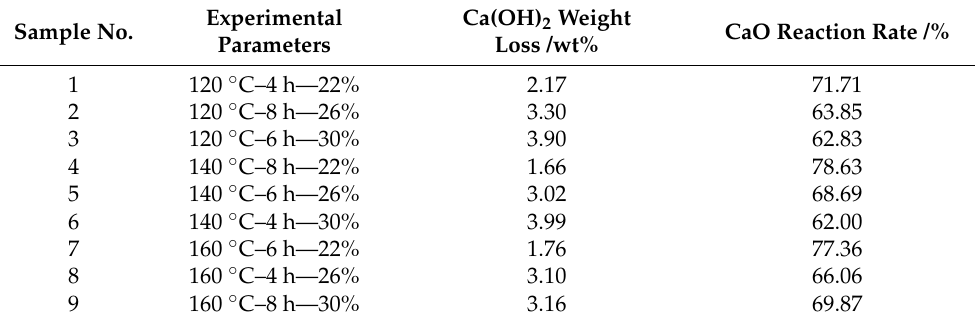
Table 3. Mass fraction of Ca(OH) 2 and CaO reaction degrees of different autoclaved samples. Sample No.